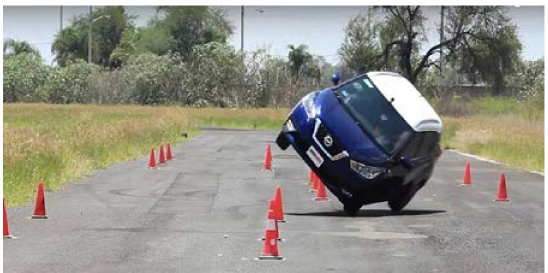
Figure 9. ISO 3888-2 Moose Test (Nissan Corporation).